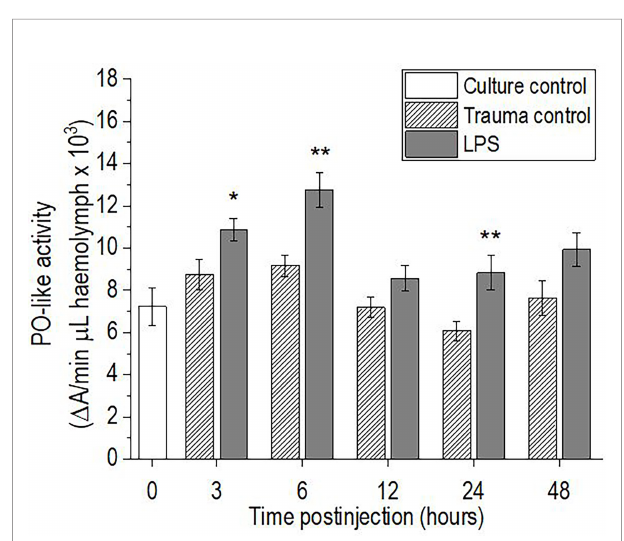
FIGURE 4 | Time-course of phenoloxidase (PO)-likeactivity for the hemolymphof P. scaber injectedwith0.5 m LDPBS (trauma control) and lipopolysaccharide (LPS; 0.5 m g/ m L). Culture control represents P. scaber not subjected to any injection. Data are means ± SE. *p <0.05; **p<0.01, versus trauma control (n=